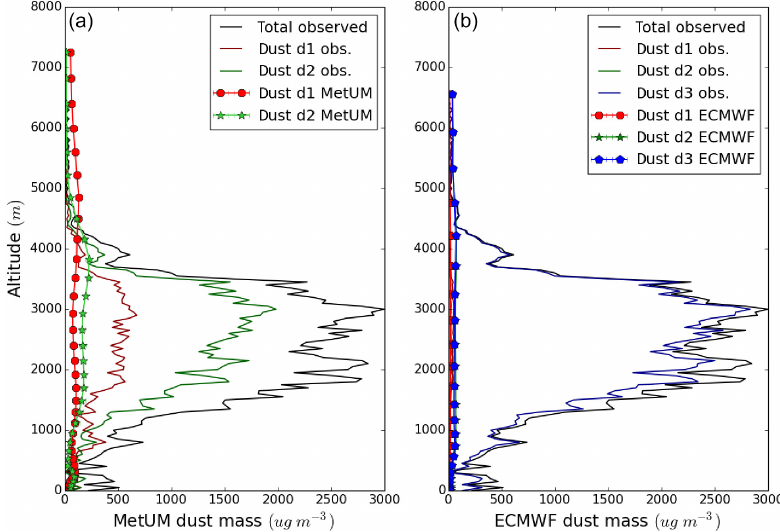
Figure 11. Case study 2: B923, 12 August, P1 (landing in Fuerteventura). (a) Dust concentration measured by the in situ instruments on the aircraft for the two MetUM dust divisions 1 (red) and 2 (green), as well as the total dust concentration measured (black). The division 1 and 2 concentration from the model is shown in a lighter shade of red and green, respectively, with markers and error bars showing the standard deviation. (b) The right-hand plot shows the same thing but for the ECMWF–CAMS size bins, with the measurements shown using lines and the model values with lines and markers for divisions 1 (red), 2 (green), and 3